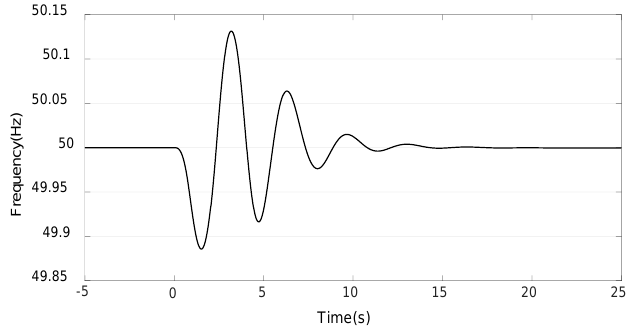
Figure 11. Frequency of microgrid when wind speed drops.